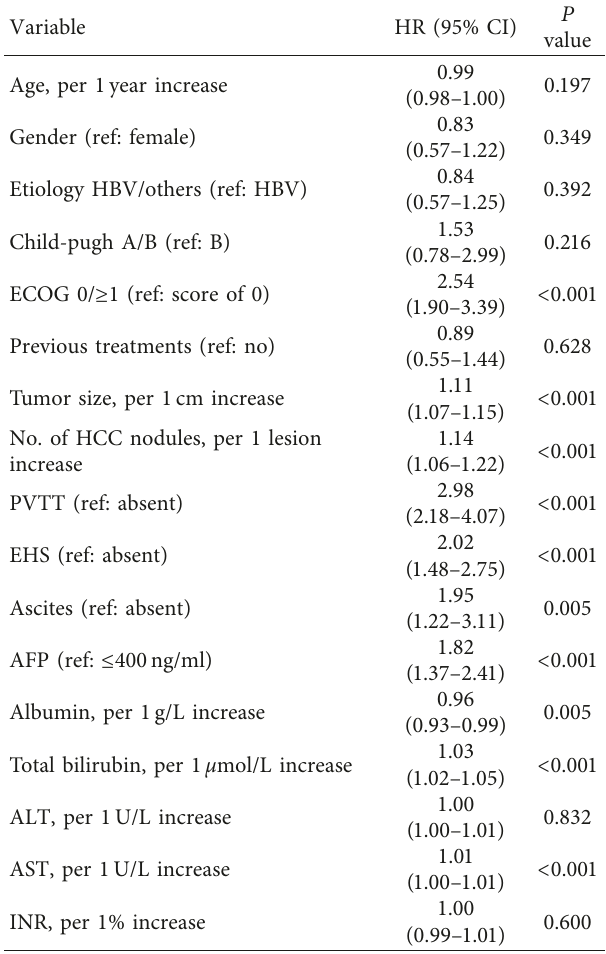
Table 3: Univariate analyses of baseline characteristics for overall